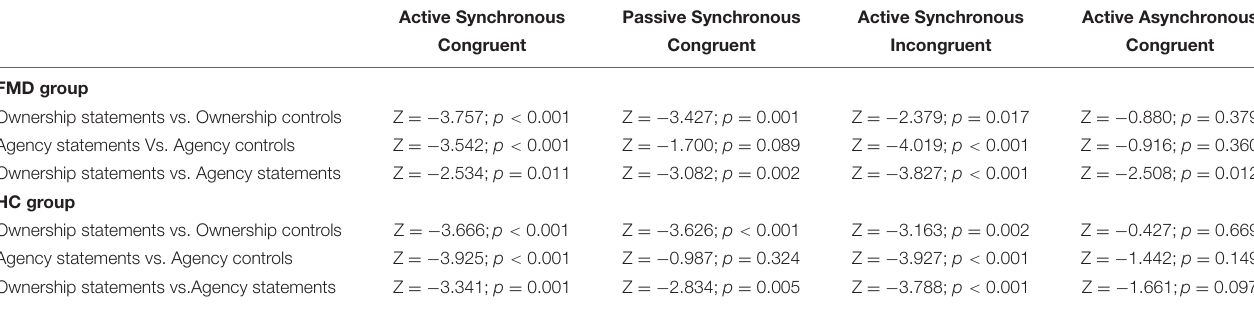
TABLE 3 | Wilcoxon signed-rank test comparisons between ownership and agency statements and their respective control statements in each condition for both